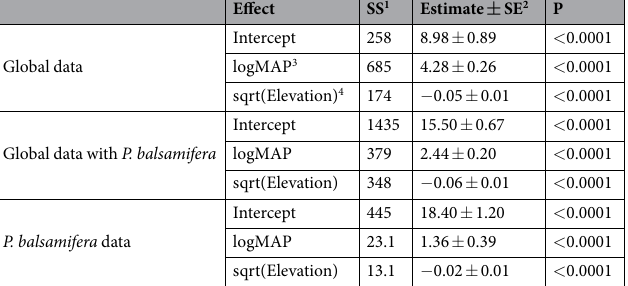
Table 2. Models of foliar Δ 13 C using each of the three data sets. 1 Sum of squares. 2 Standard error. 3 Base 10 logarithm of Mean Annual Precipitation (mm). 4 Square root of elevation (m).